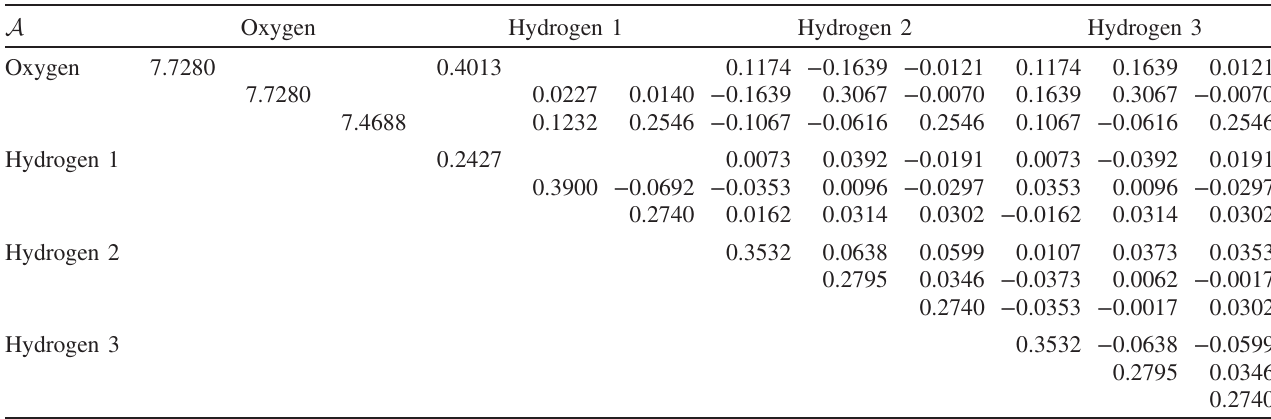
TABLE VI. A matrix for H 3 O þ . The sum rule yields (9.9997, 9.9997, 9.9997) for i , j ¼ xx , yy , zz , as 10 electrons are present in the system.